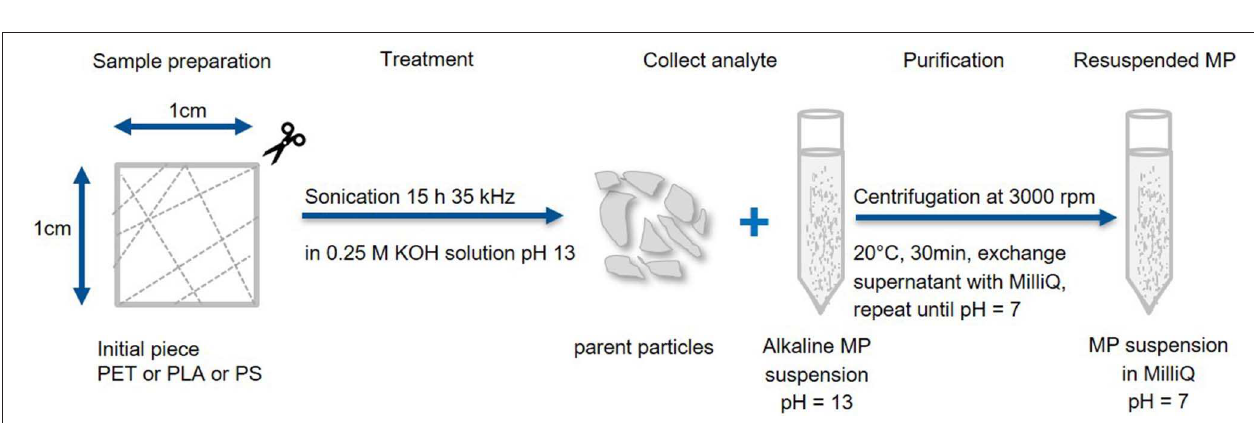
FIGURE 1 | Fragmentation and work up scheme A. Production of small fragments and deposition on a gold-coated polycarbonate filter as well as recovery of the parent particle.